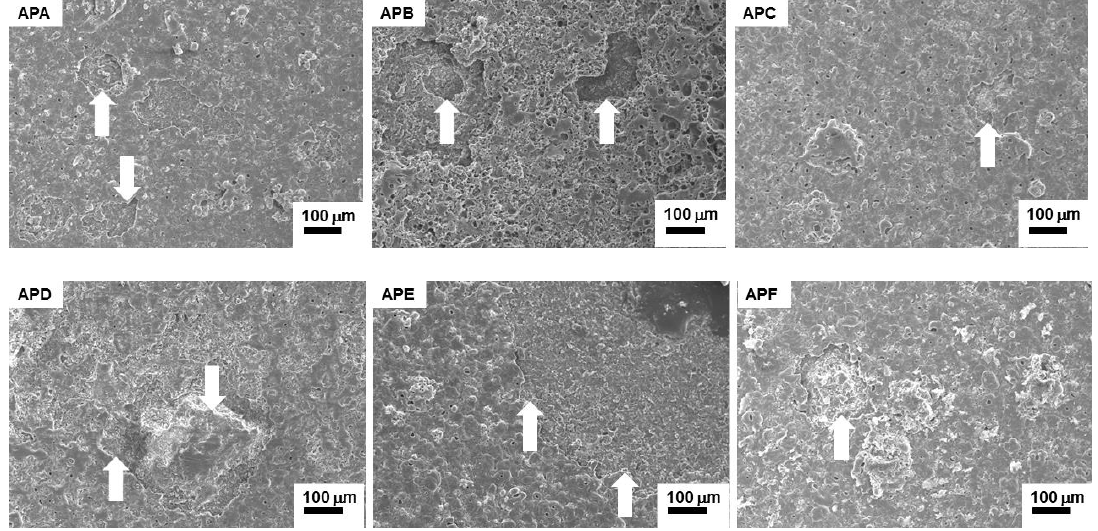
Figure 14. The surface morphologies of PEO coatings after potentiodynamic polarization test.